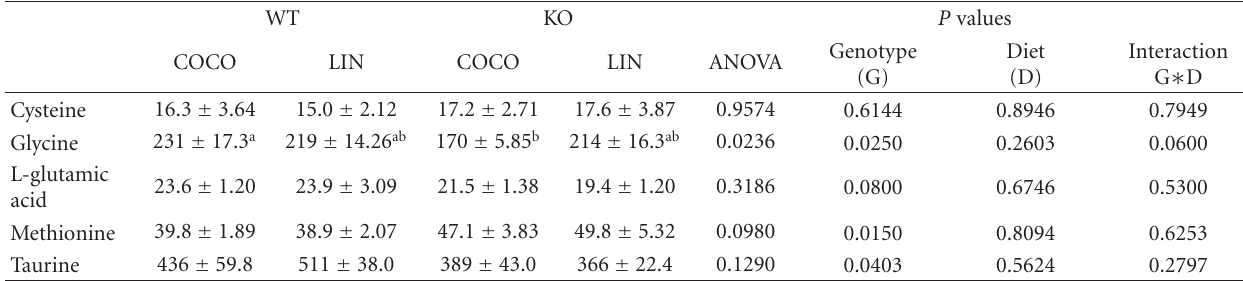
Table 5: Plasma concentrations of amino acid involved in cysteine metabolism in WT and PPAR α -null (KO) mice fed diets containing either saturated FA (COCO diet) or ALA (LIN diet) for 8